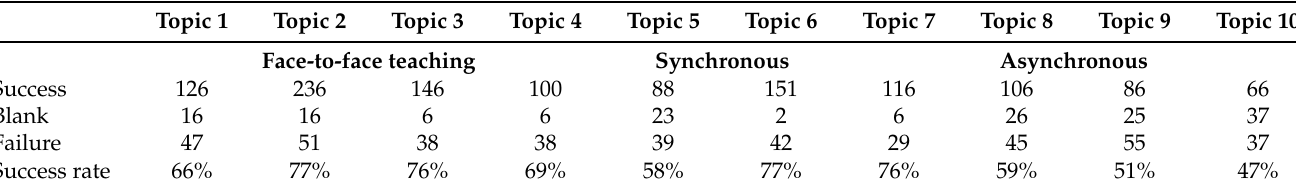
Table 12. Final test results by topics Year 2019–2020.